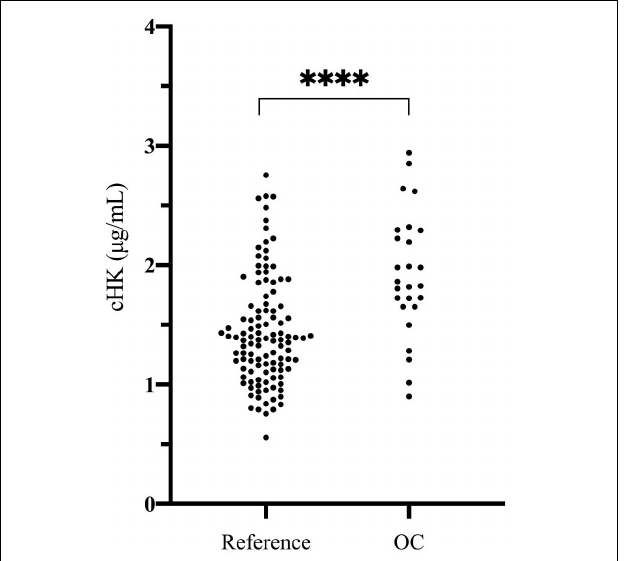
FIGURE 6 | Cleaved H-kininogen levels determined in citrate stabilized plasma from a reference population of 120 healthy blood donors (60 women and 60 men) (Reference) and in citrate stabilized plasma from 26 healthy female blood donors subscribed to oral contraceptives (OC). The median plasma concentration of cHK in the reference population was 1.38 (0.82 – 2.56) µ g/mL. The median plasma concentration of cHK in women using oral contraceptives was significantly higher than in the reference population [1.84 (0.94 – 2.91) µ g/mL], ∗∗∗∗ p < 0.001.